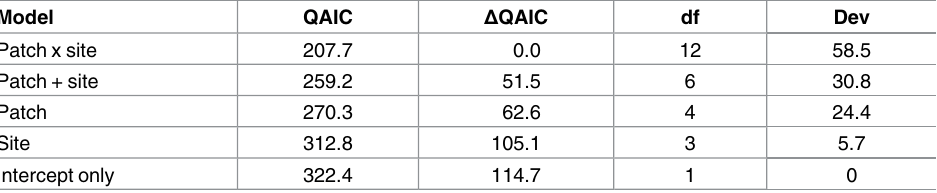
Table 3. Factors affecting the density of tortoises (second stage). Results of generalizedlinear models (GLM) with a log-linkand a quasipoisson error structure. QuasiAIC was used for model selection.Degreesof freedom (df) and percentageof explained deviance(Dev) are also shown.